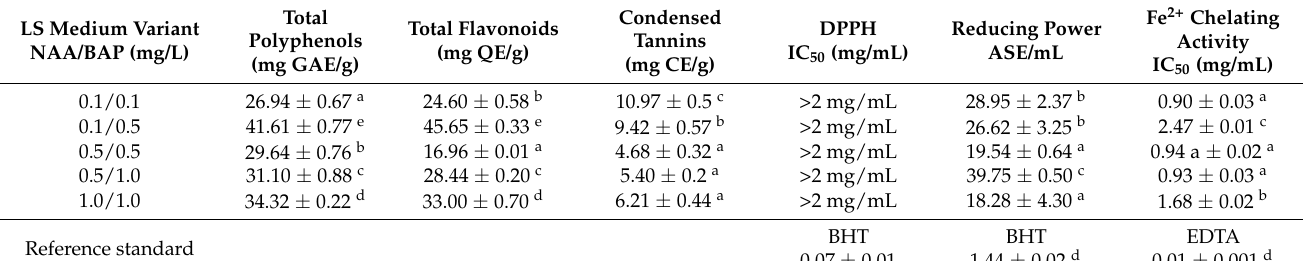
Table 3. Total phenolic, flavonoid, and condensed tannin content, free radical scavenging activity (DPPH) test, reducing power, and ferrous ion chelating activity of methanol extracts obtained from biomass of R. montana bioreactor cultures grown on LS medium variant supplemented with different concentrations of NAA/BAP (0.5/0.5, 0.1/0.5, 1.0/1.0, 0.1/0.1 mg/L), after 5-week growth